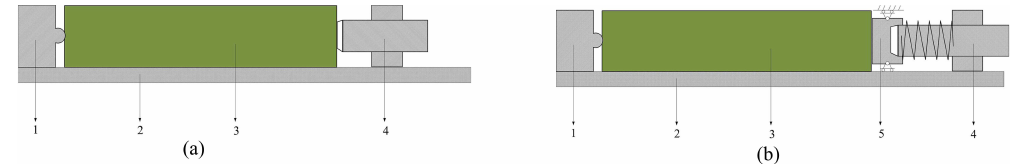
Figure 5. Pre-tightening mechanism. (a) traditional pre-tightening mechanism; (b) proposed pre-tightening mechanism; 1, mobile platform; 2, fixed platform; 3, piezoelectric actuator; 4, bolt; 5, adjustable pre-load force block.